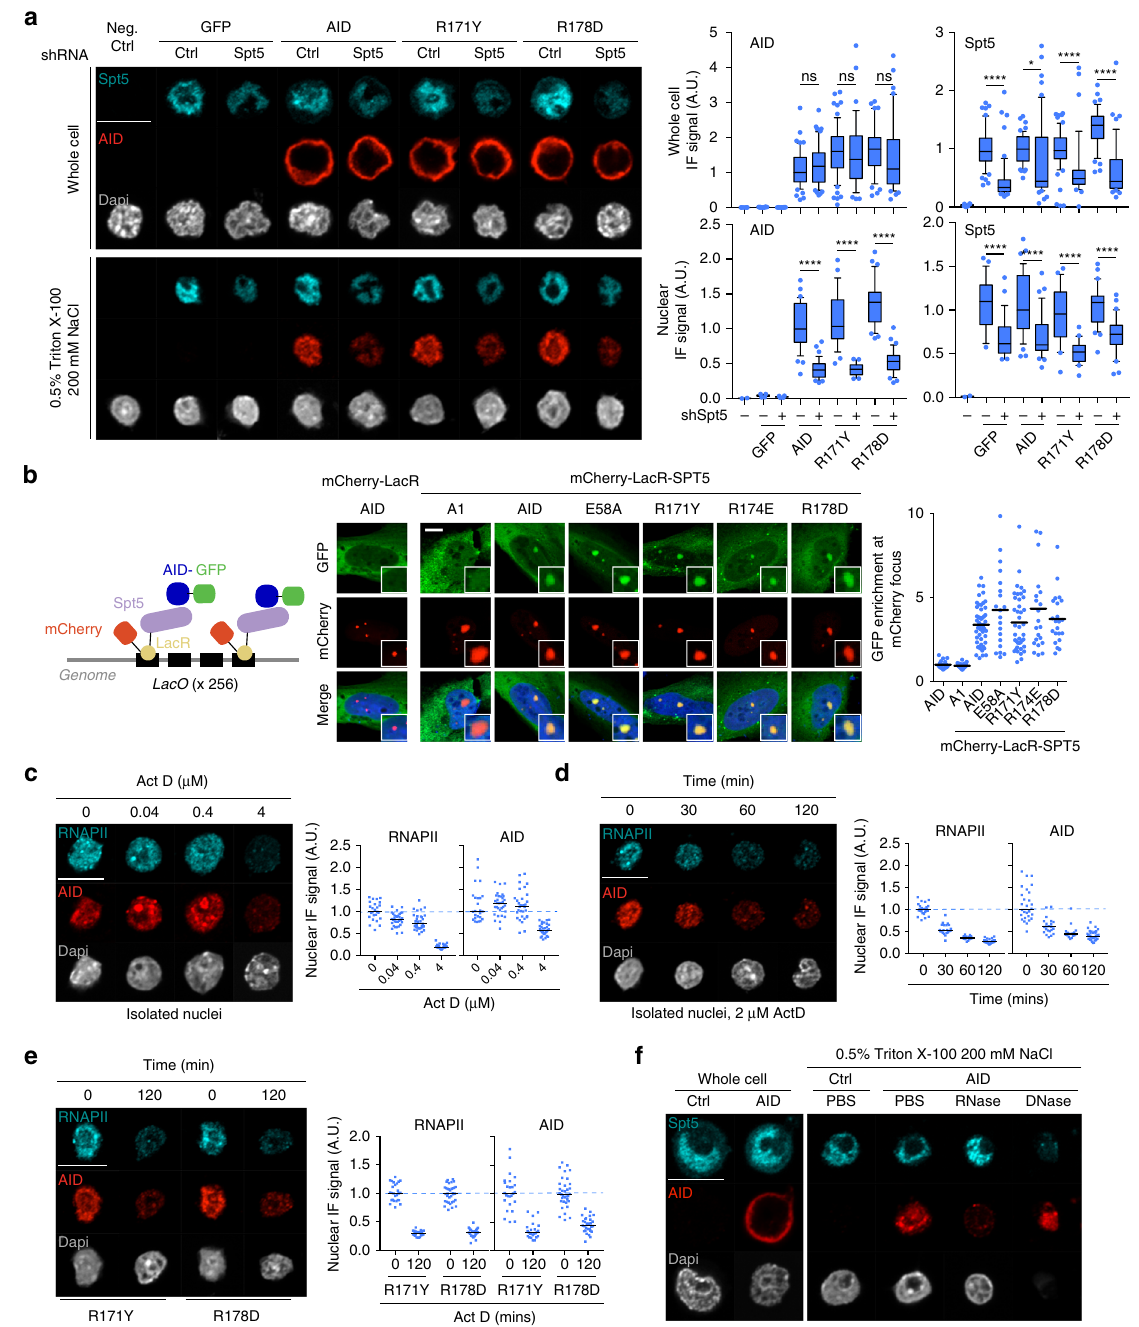
Fig. 5 Requirements for chromatin association of AID. a , c – f Representative confocal microscopic images of GFP, immuno fl uorescence (for AID and Spt5 or RNAPII) and DNA staining (Dapi) in reconstituted AID-de fi cient CH12 B cells. Nuclear wash was carried out as in Fig. 4. Magni fi cation 630×. Scale bar, 10 μ m. a (Left) CH12 cells were transduced with either a shRNA control or against Spt5 as indicated. (Right) Box plots (25 – 75 percentiles with median and 10 – 90 percentiles whiskers of AID and Spt5 signal from individual whole cells or isolated nuclei, normalized to the median of wt AID. One of the two independent experiments is plotted (21 – 66 cells per condition). Differences were evaluated by unpaired, two tailed t -test (ns, not signi fi cant, * P < 0.05, **** P < 0.0001). b (Left) Schematic of the lacO /LacR system. (Middle) Representative confocal microscopic images of GFP or mCherry and their overlay, including DNA (Dapi). Small boxes highlight typical mCherry foci. (Right) Quanti fi cation of GFP signal at each mCherry focus, normalized to non-focus nuclear GFP signal (dots). The mean for each construct (bars) is shown. Compilation of two independent experiments. Magni fi cation 400×. Scale bar, 10 μ m. c As in a , but cells were treated for 60 min with DMSO (0) or the indicated dose of Actinomycin D (Act D) prior to plating and washing. d As in a , but cells were treated with DMSO ( t = 0) or for various times with 2 μ M Act D prior to plating and washing. e As in a for cells expressing AID R-mutants treated with either DMSO or 2 μ M Act D for 120 min. c – e Average AID and RNAPII signal for individual nuclei (dots), with bars indicating population median, normalized to the median of untreated cells (dotted line), with 17 – 32 cells per condition from 1 experiment. f As in a but nuclei were incubated at 37 °C with PBS control, RNAse or DNase during nuclear wash. Images are representative of 42 – 78 cells per condition and 2 independent experiments. IF immuno fl uorescence, A.U. arbitrary